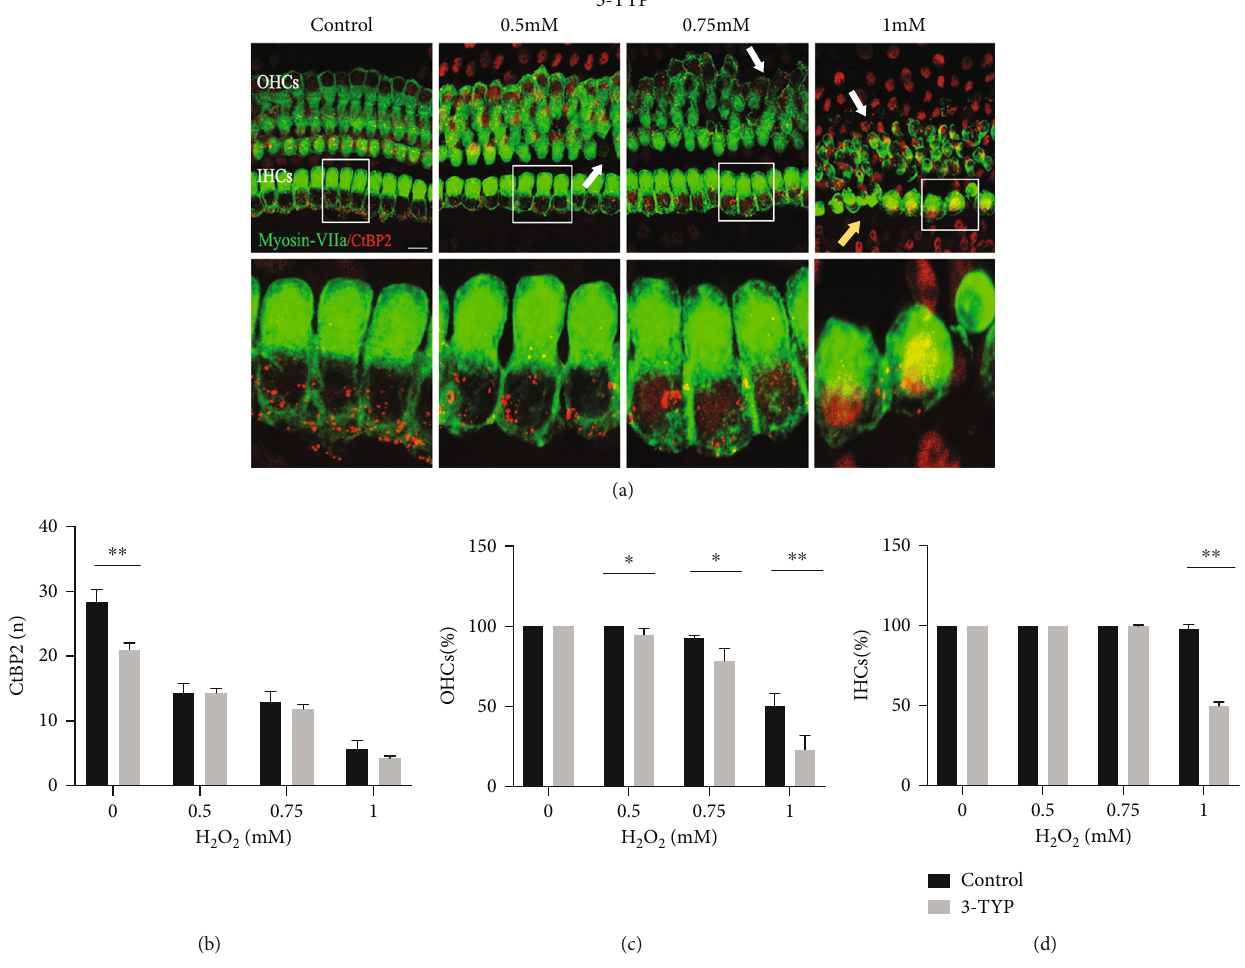
Figure 2: H O induces aggravated oxidative damage to cochlear by suppression of SIRT3. (a) Representative images of ribbon synapses 2 2 (red) and HCs (green) in the middle region of cochlear explants in 0, 0.5, 0.75, and 1 mM groups pretreated with 3-TYP. The white arrows indicate OHC damaged areas. Yellow arrows indicate IHC damaged areas. (b) Comparison of ribbon synapse at each concentration between matched and 3-TYP groups. (c) Comparison of OHC survival at each concentration between matched and 3-TYP groups. (d) Comparison of IHC survival at each concentration between matched and 3-TYP groups. Data are shown as means ± SD ( n = 5 in each group). ∗ P < 0 : 05 , ∗∗ P < 0 : 01 , and ∗∗∗ P < 0 : 001 . Scale bar = 10 μ